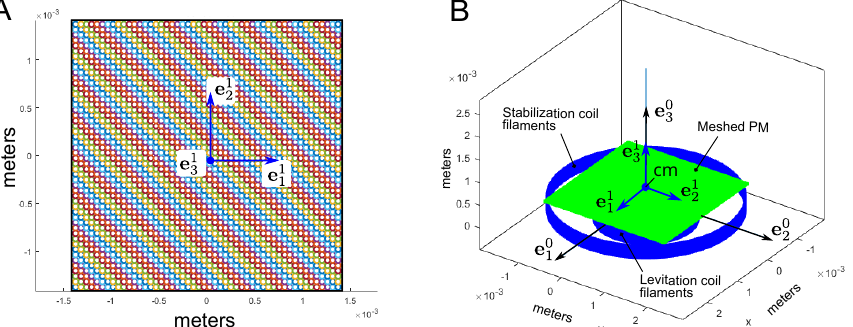
Figure 5. ( A ) The square-shape PM with a side length of 2.8mm is meshed by 2500 circular elements with a radius of R e = 2.8025 × 10 − 5 m ; ( B ) 3D geometrical scheme of HLMA for eddy current